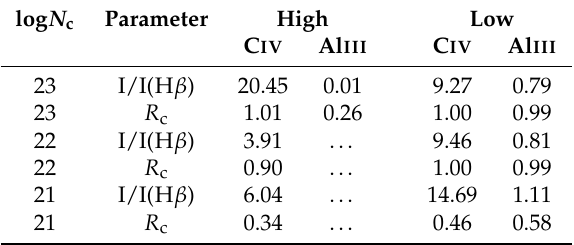
Table 1. Intensity and collisional excitation as a function of column